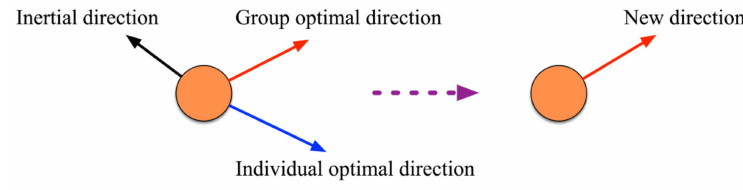
Figure 4. Schematic diagram of particle search for optimization.